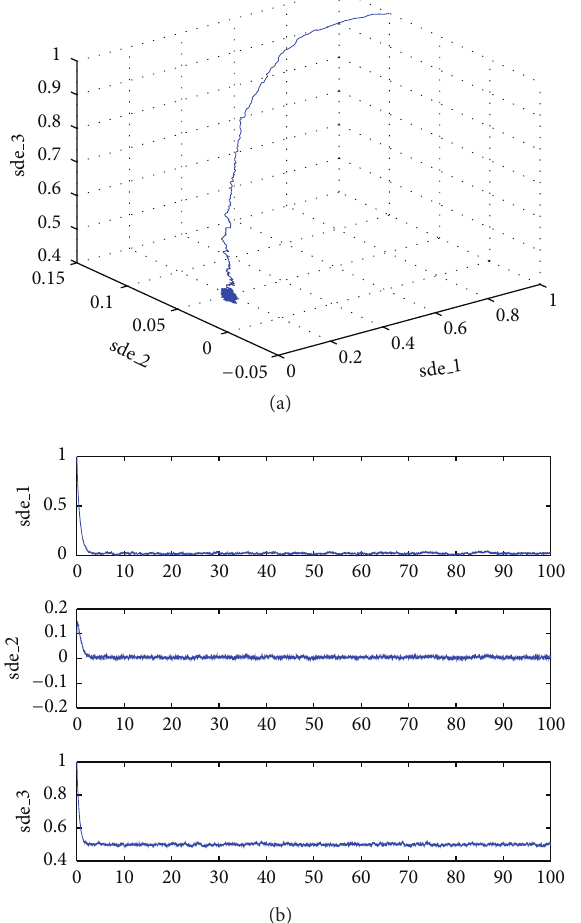
Figure 10: The attractor and the time series of the deterministic Lorentz-R¨ossler